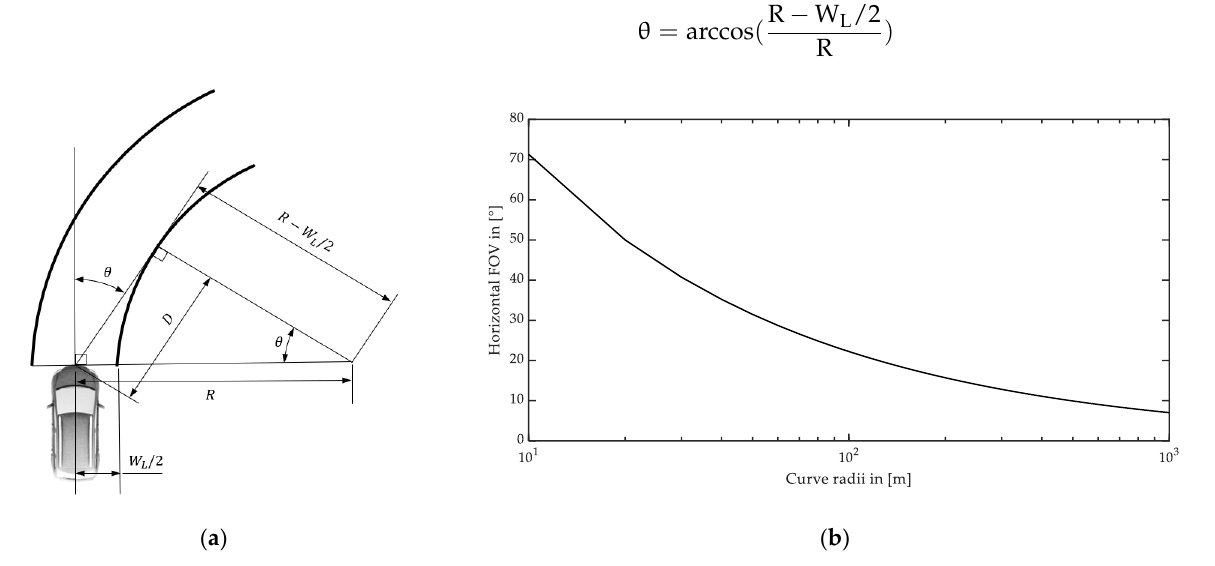
Figure 3. Detection area in a curve: ( a ) schematic to calculate the horizontal angle to cover the full lane width in a curve with radius R according to [29]; ( b ) required entire horizontal FOV for different curve radii.